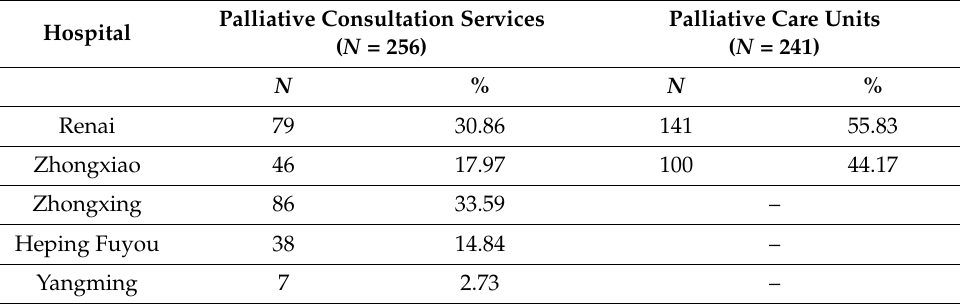
Table 4. Percentage utilization of two types of palliative care